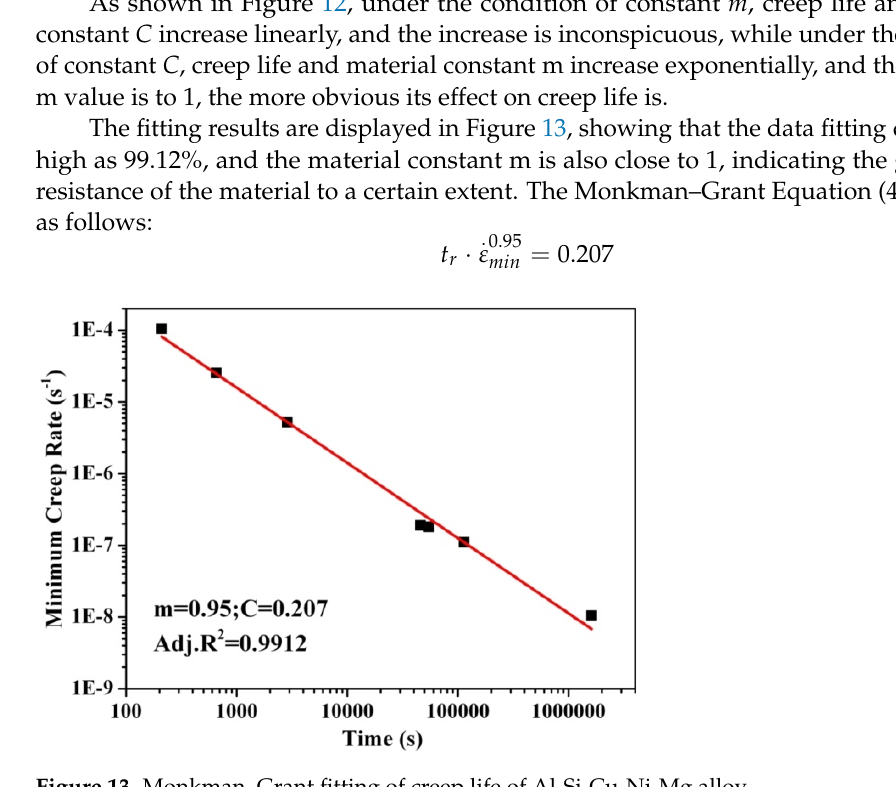
Figure 12. The influence of C and m constants in the Monkman–Grant model on the fracture life under the condition of constant minimum creep rate.